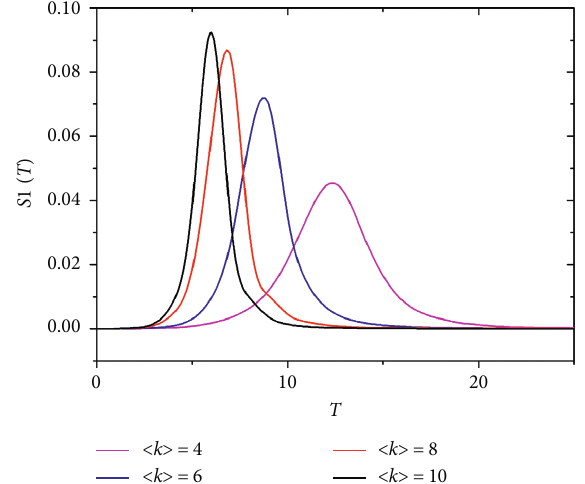
and λ under the parameter 1 2 � c � 0 . 1 2